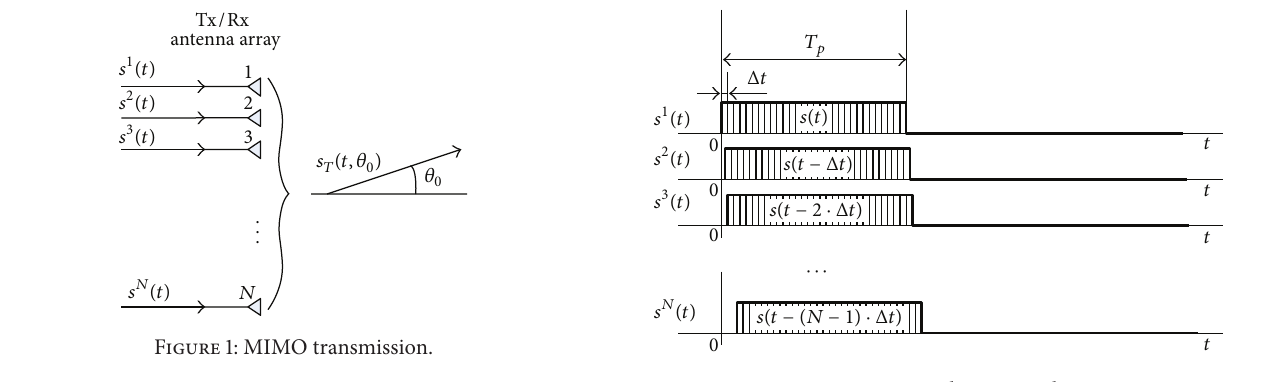
Figure 2: Circulating